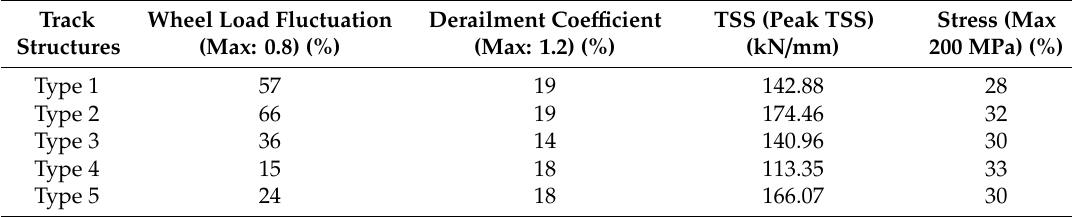
Table 11. Evaluation results of track performance (ballasted track structures).